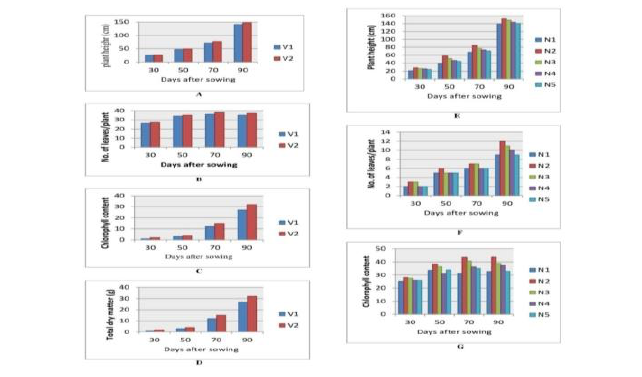
Figure 1: Illustration: A: Effect of varieties on plant height of baby corn; B: Effect of varieties on No. of leaves/plant of baby corn; C: Effect of varieties on chlorophyll content (spad value) of baby corn; D: Effect of varieties on total dry matter (g) of baby corn; E: Effect of different sources of nitrogen on plant height of baby corn; F: Effect of different sources of nitrogen on No. of leaves/plant of baby corn; G: Effect of different sources of nitrogen on chlorophyll content (spad value) of baby